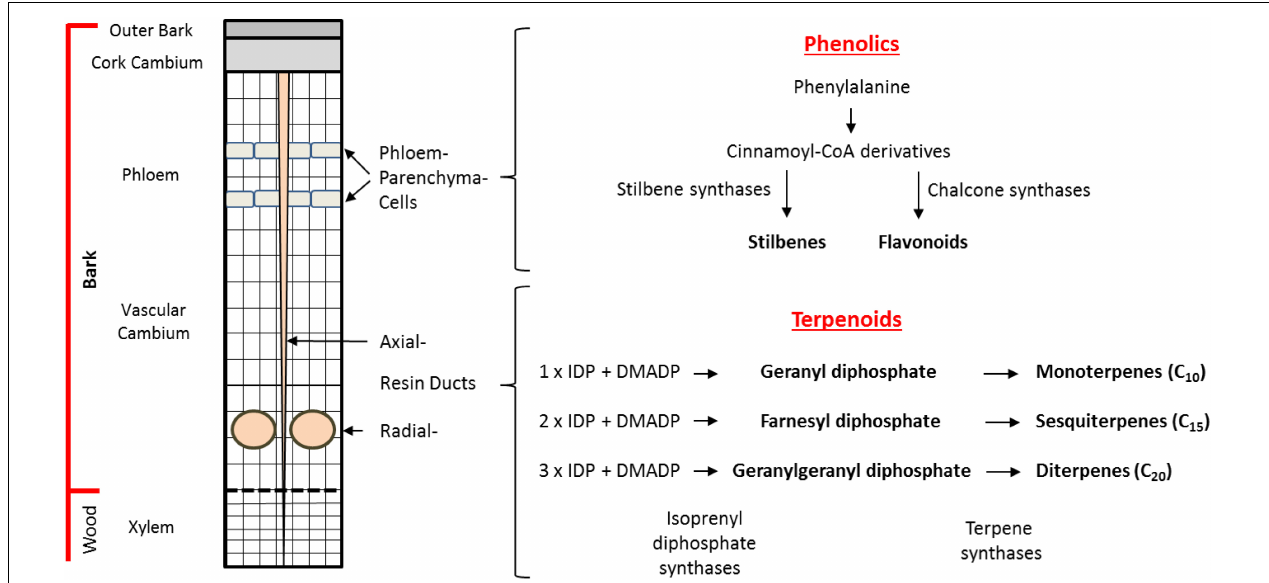
FIGURE 1 | Biosynthesis and storage of defense compounds in Norway spruce bark. Depicted on the left is a schematic cross section of the cambial region of the trunk of a mature tree. Phenolic compounds are localized in bands of phloem parenchyma cells in the phloem. Terpenoid resin compounds are localized in radial resin ducts in the xylem and in axial resin channels that traverse both the xylem and phloem. An outline of the biosynthetic pathways to terpene and phenolic defense compounds is given on the right. The major phenolic compounds (stilbenes, flavonoids) are synthesized in the phloem parenchyma cells from phenylalanine with stilbene synthases (STSs) and chalcone synthases (CHSs) being the key branchpoint enzymes. The terpenoid resin compounds are synthesized in the epithelial cells lining the resin ducts from the C 5 units isopentenyl diphosphate (IDP) and dimethylallyl diphosphate (DMADP). The isoprenyl diphosphate synthases catalyze the formation of the intermediates geranyl diphosphate (GDP), farnesyl diphosphate (FDP), and geranylgeranyl diphosphate (GGDP). These intermediates are converted into monoterpenes (C 10 ), sesquiterpenes (C 15 ), and diterpenes (C 20 ), respectively, by the action of terpene synthases